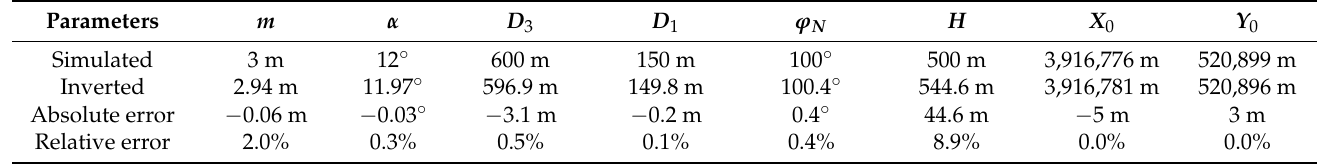
Table 2. Comparisons between the inverted and simulated geometric parameters of the